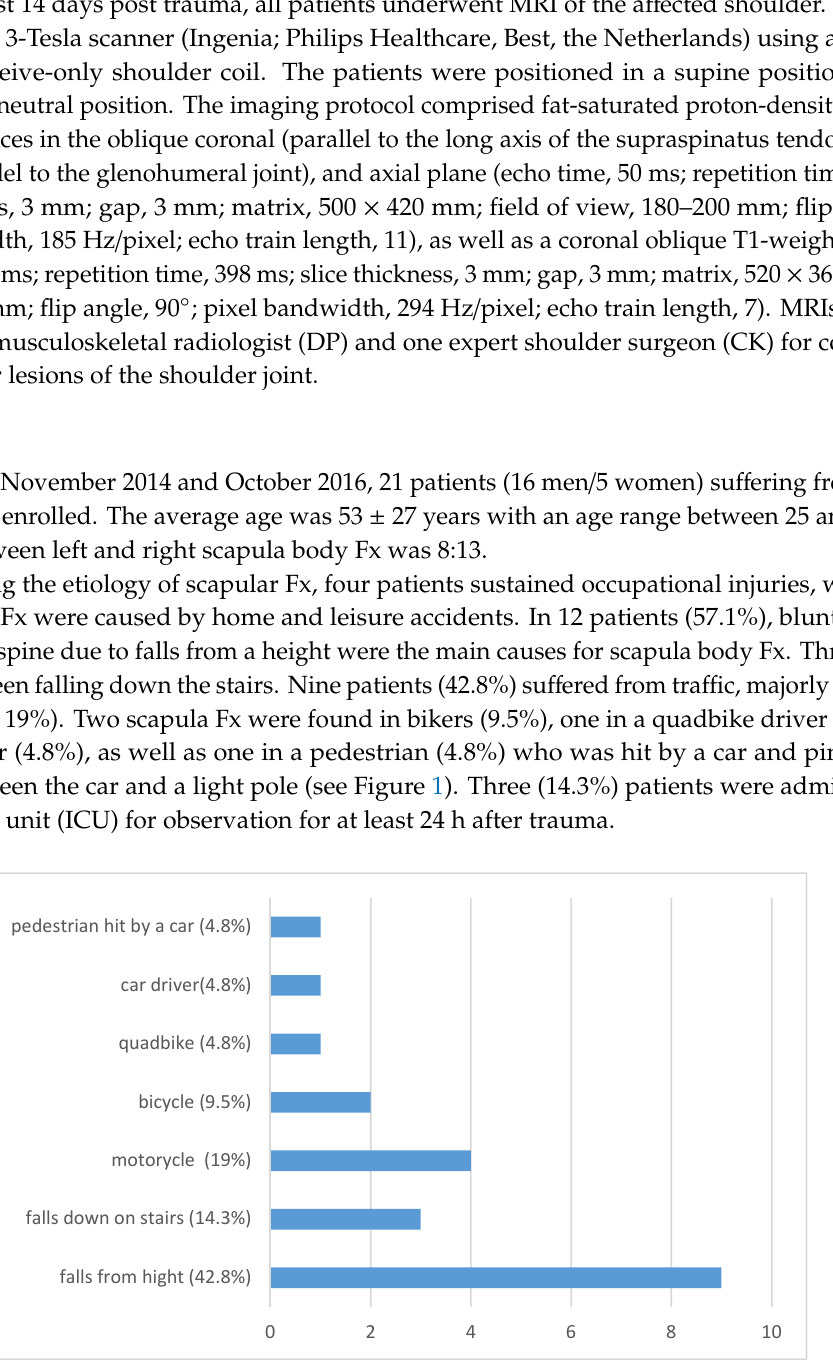
Figure 1. Encountered trauma mechanism which led to scapula